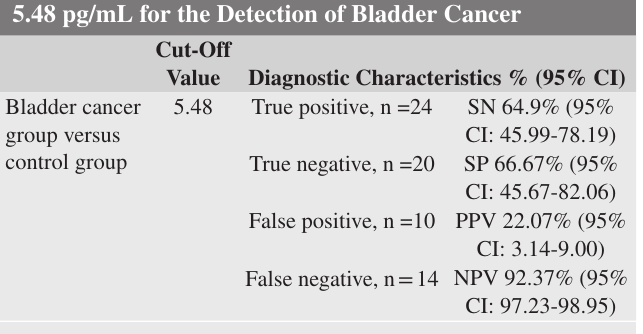
Table 2. Performance of AHNAK2 Enzyme-Linked Immunosorbent Assay Urine Test at Cut-Off Value of